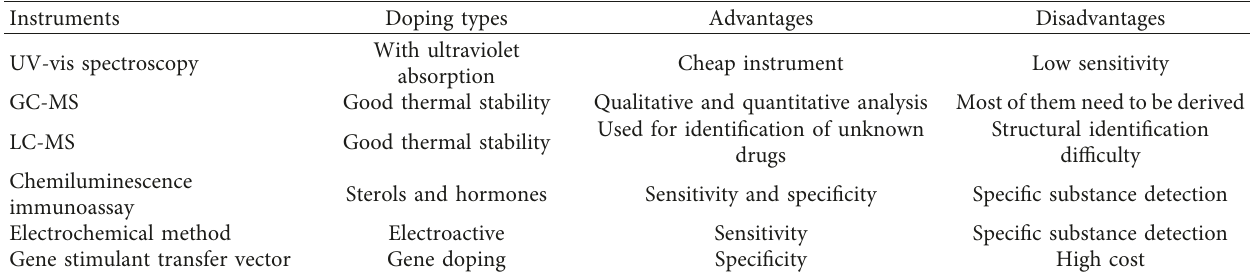
Table 1: Advantages and disadvantages of several analytical techniques in doping-control.